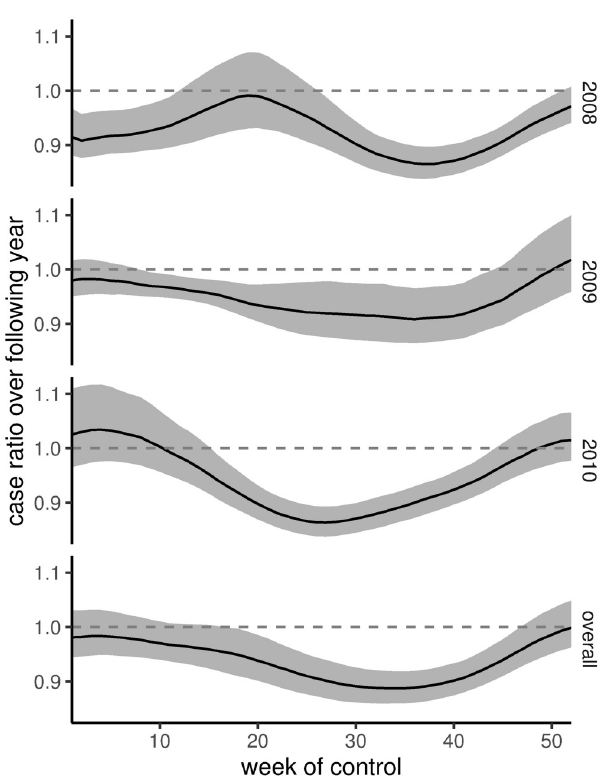
Fig 3. The effect of mosquito control as a function of the week in which it was applied. Summary of the posterior predicted effect of mosquito control implemented in a given week of the year on the number of cases in the following year (relative to the number of cases expected without control). Black lines indicate the posterior median, while gray ribbons indicate the 80% credible interval. The first three panels show the results for control implemented in the years 2008-2010, and the last panel shows the overall effect of control impelmented in a given week of the year, summing over all three years. For example, mosquito control applied in week 37 of 2008 would have prevented about 13% of the human cases over the following year (i.e., the caseload would have been 87% of the expectation without control).